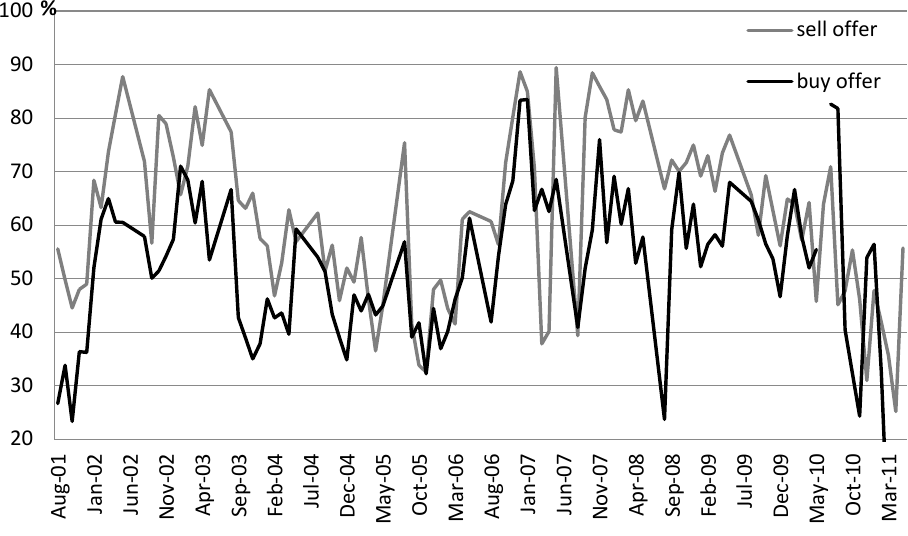
Figure 2. Water allocation price clustering at whole dollar digit ending in zero (all offers).